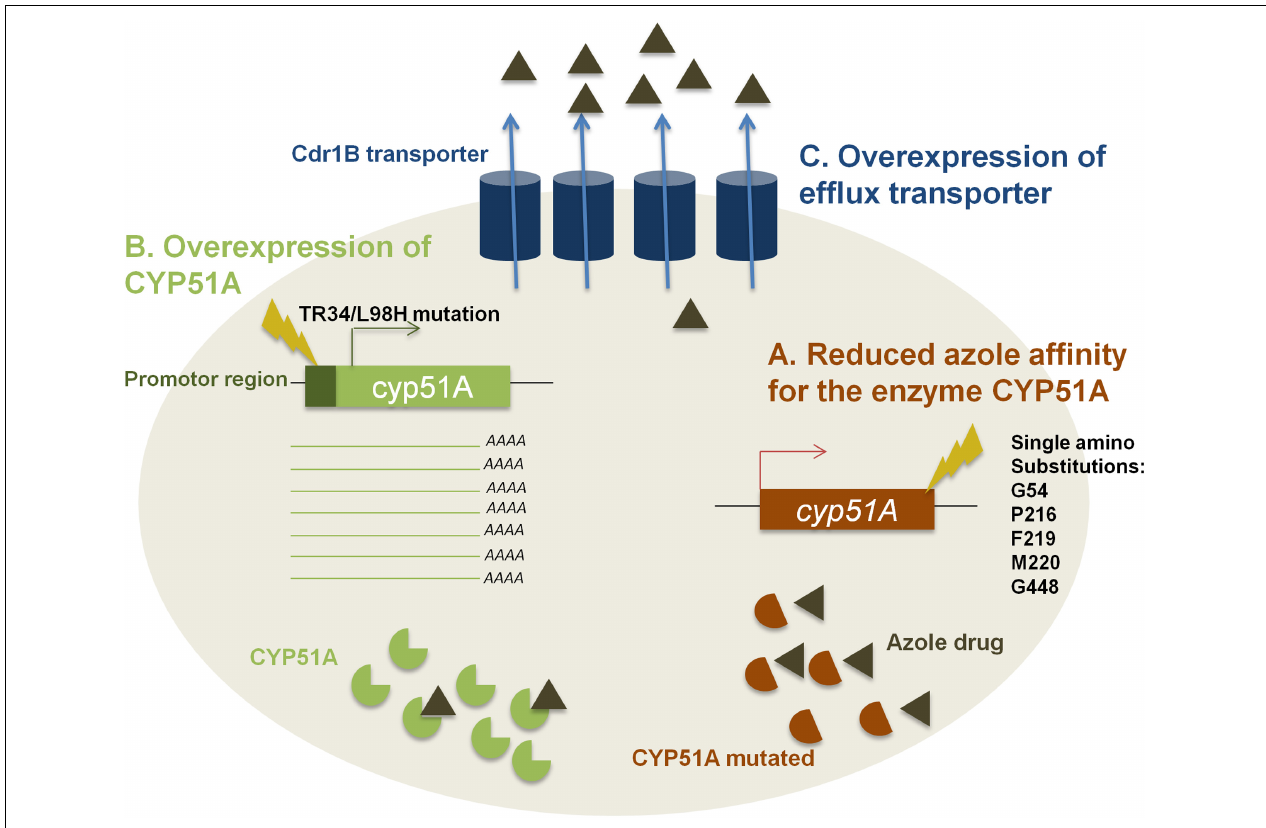
FIGURE 1 | The three mechanisms of resistance to azole drugs. (A) Presence of mutations responsible for substitution causing structural modifications of CYP51A enzyme leading to a reduced azole affinity. (B) Overexpression of cyp51A gene due to a 34-bp insertion in its promoter region combined with a substitution at codon 98 of leucine to histidine (TR34/L98H) causing an increase in cellular CYP51A level. (C) Overexpression of the genes coding for efflux transporter causing a reduced intracellular accumulation of azole